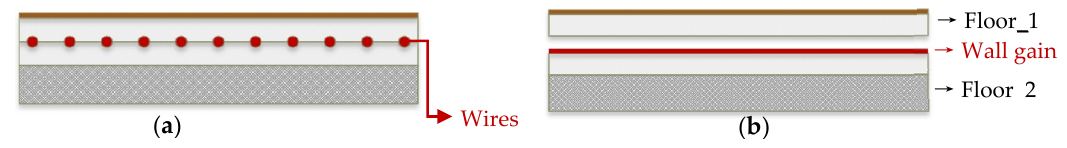
Figure 2. Conventional configuration of an EHF (electrically heated floors) ( a ); and configuration of the floor in TRNSYS with the added fictitious zone and the wall gain ( b ).